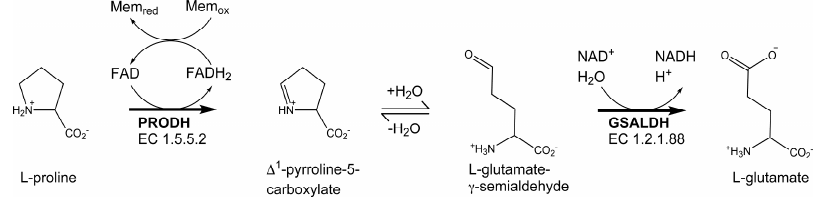
Figure 1. The reactions catalyzed by PutA.